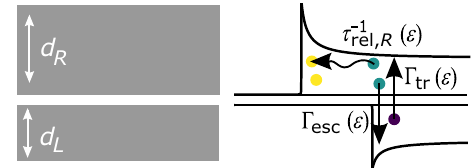
FIG. 8. Left: a schematic of the typical superconducting bilayer away from the Josephson-junction region. The first film is coupled to a second film (both in gray) by a large-area insulat- ing barrier (white). Right: the quasiparticle band diagram for the two thin aluminum films. Quasiparticles in the higher gap elec- trode can tunnel into the lower-gap electrode at rate (cid:12) tr ((cid:8)) . In the ((cid:8)) top film, quasiparticles can relax to lower energies at rate τ − 1 rel, R (see Appendix B 3) or tunnel back at rate (cid:12) esc ((cid:8)) . The three rates of Eq. combine to give the effective trapping rate τ − 1 tr